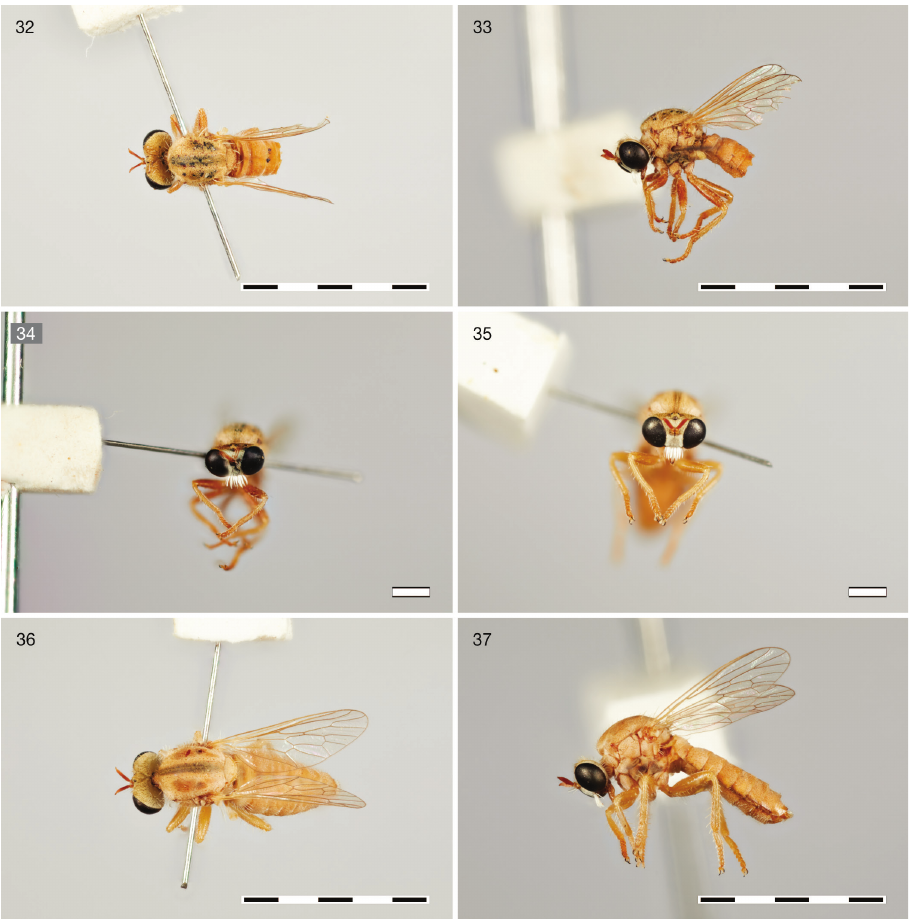
Figures 32–37. Microphontes kryphios sp. n.: 32 ♂ Holotype (NMSA-DIP-74620), dorsal (Morph- bank #861837) 33 same, lateral (#861839) 34 same, head anterior (#861841) 35 ♀ Paratype (NMSA- DIP-4775), head anterior (#861844) 36 same, dorsal (#861846) 37 same, lateral (#861848). Scale bars : 5 mm ( 32–33, 36–37 ), 1 mm ( 34–35 anepisternum and features of the male terminalia such as the long postero-median projection on the hypandrium and shape of the gonostyli. Description. Head : wider than high, brown; vertex and compound eyes at same level; facial swelling indistinct, only lower facial margin slightly developed, silver pubes- cent; mystax white macrosetose, restricted to lower facial margin, short, reaching tip of proboscis; ommatidia of same size; postgena posterior margin simple, smooth; frons (at level of antennal insertion) slightly diverging laterally, grey pubescent, yellowish setose; ocellar tubercle greyish-brown pubescent, light brown setose; vertex greyish-light brown pubescent, yellowish to light brown macrosetose; median occipital sclerite (m ocp scl) with several yellowish macrosetose; postocular (pocl) setae slightly angled anteriorly